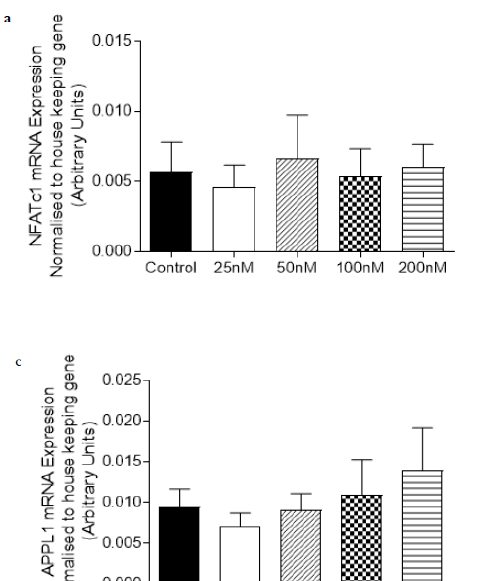
Figure 5. The abundance of mRNA expressed for markers involved in adiponectin signalling and oxidative capacity in human primary rectus abdominus -derived myotubes obtained from individuals that are obese treated for 24 h with O-1918 (25–200 nM). mRNA expression was normalised to housekeeping gene Cyclophilin and grouped data is reported as mean (arbitrary units) ± SEM. ( a ) Nuclear Factor of Activated T-Cells calcineurin dependent 1 (NFATc1); ( b ) Peroxisome proliferator-activated receptor gamma co activator 1-alpha (PGC1 α ); ( c ) Adaptor protein containing pleckstrin homology domain, phosphotyrosine binding domain and leucine zipper motif 1 (APPL1); ( d ) Adaptor protein containing pleckstrin homology domain, phosphotyrosine binding domain and leucine zipper motif 2 (APPL2); ( e ) Adiponectin Receptor 1 (AdipoR1).